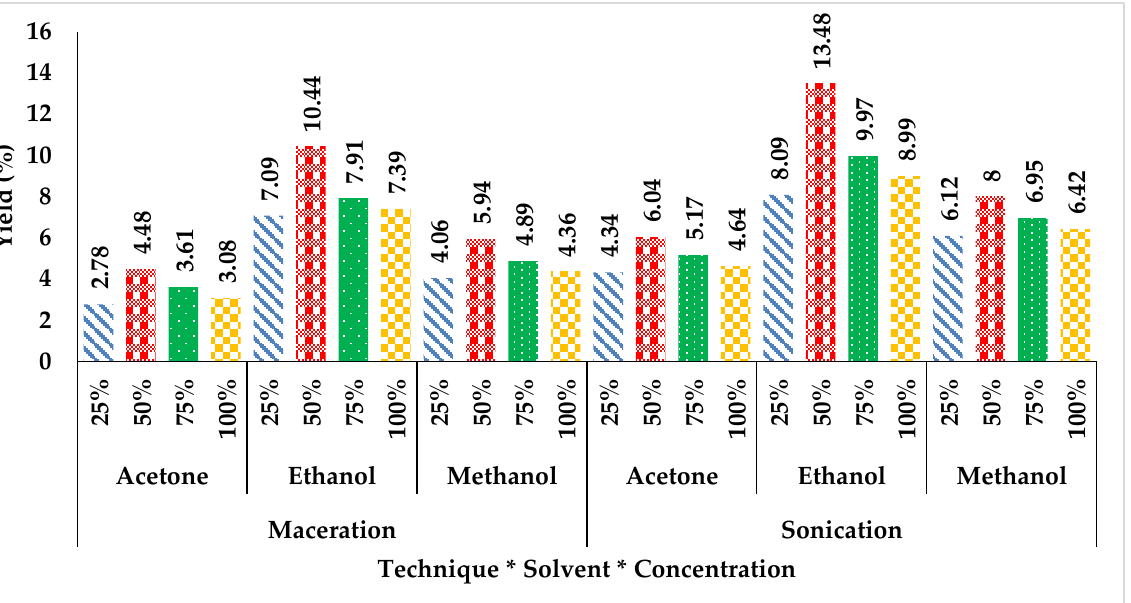
Figure 2. Yield (%) of banana peel extracts by sonication and maceration.